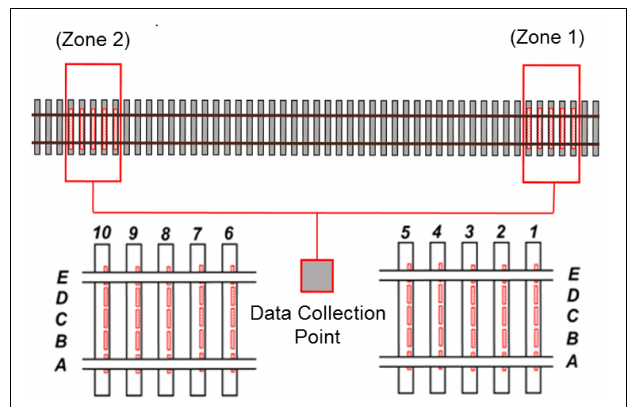
FIGURE 3 | Field site layout with ten sleepers in two test zones (Wolf,